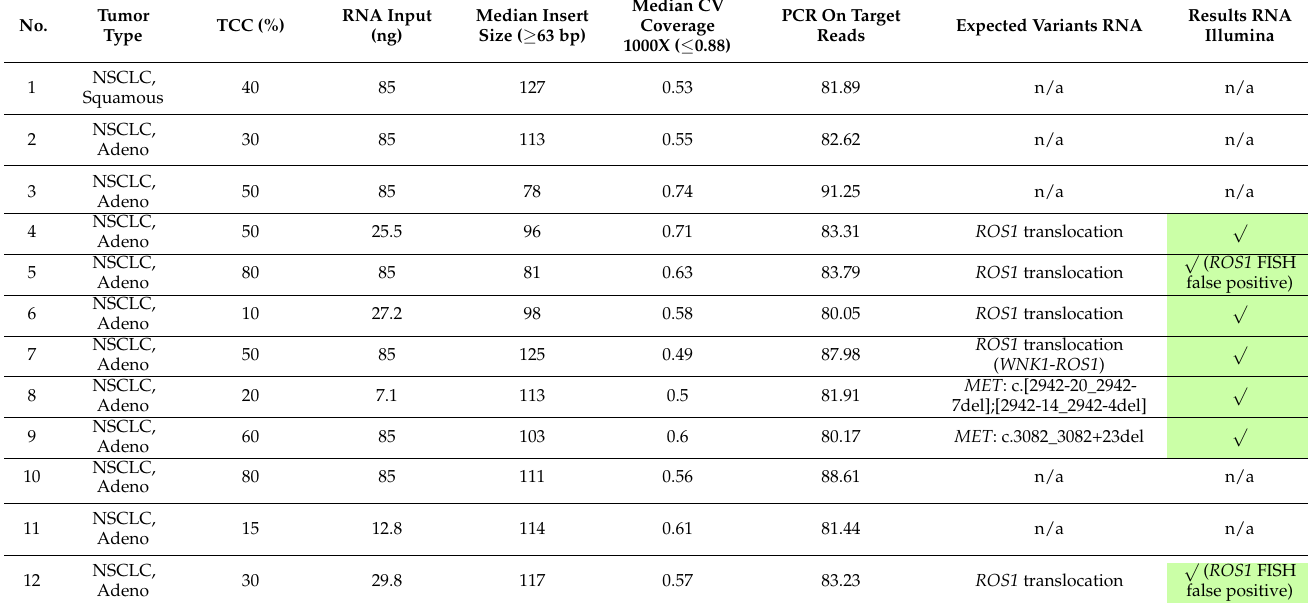
Table 4. Results and quality scores of the 44 RNA samples analyzed with the TruSight Tumor 170